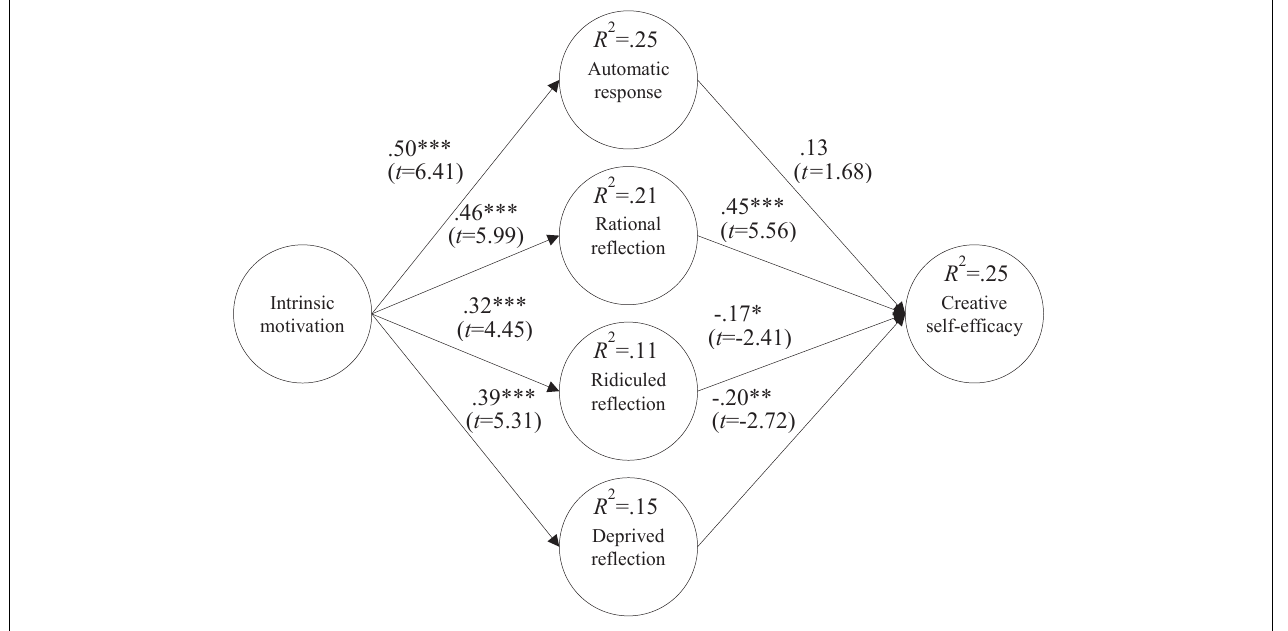
FIGURE 2 | Research model verification. ∗ p < 0.05, ∗∗ p < 0.01, ∗∗∗ p < 0.001.